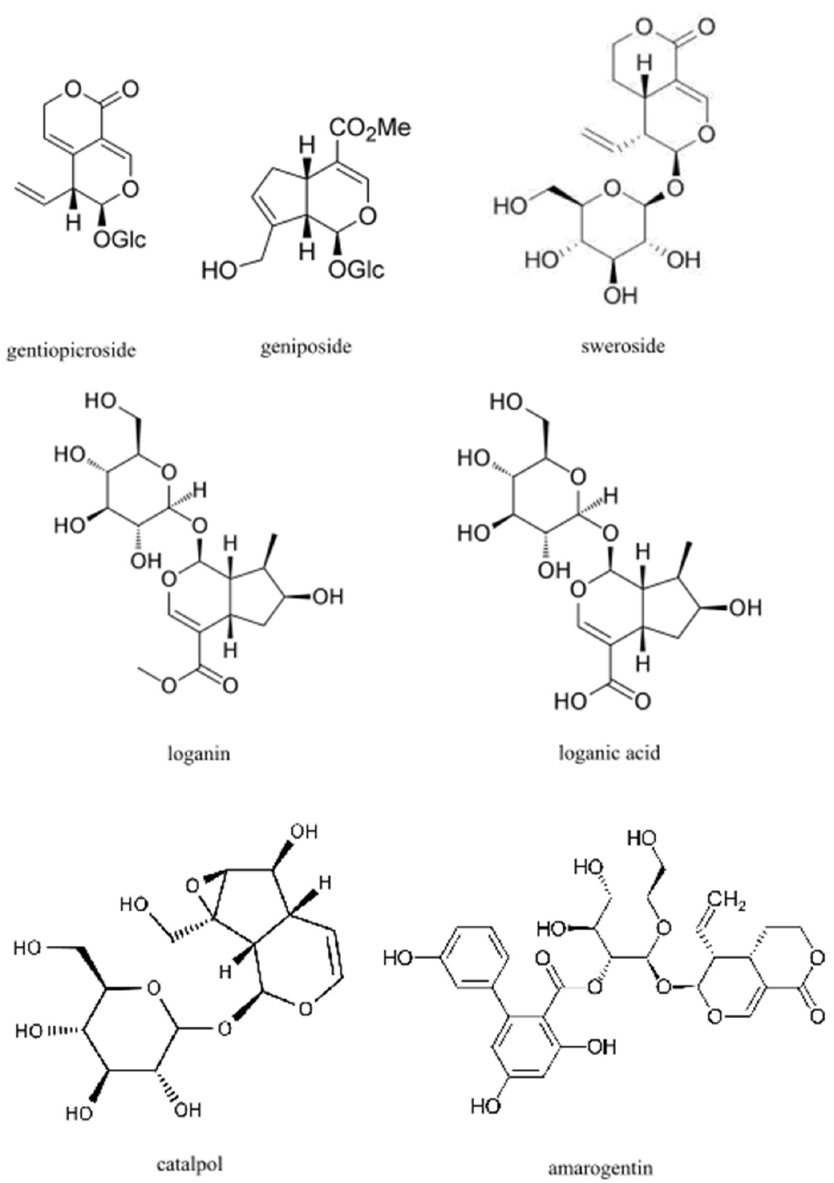
Figure 2. Chemical structures of main iridoids.